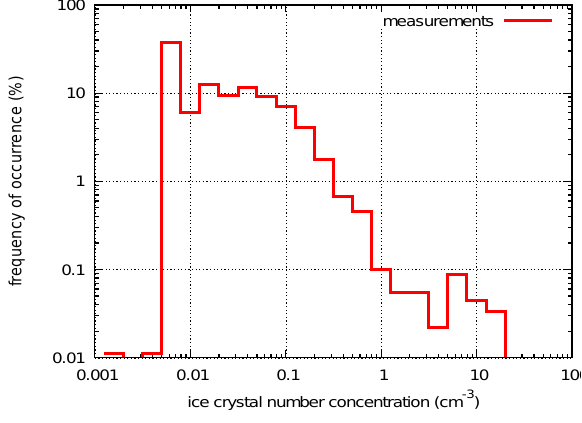
Fig. 3. Measured ice crystal number concentration distribution in the temperature range T < 200K, from Krämer et al.